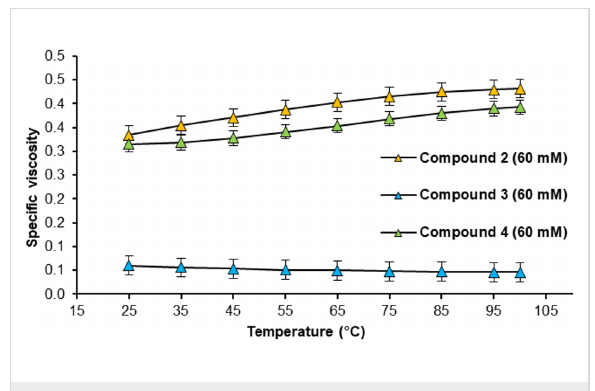
Figure 7: Specific viscosity of compounds 2 , 3 and 4 in Nynas NS8 in dependency to the temperature.